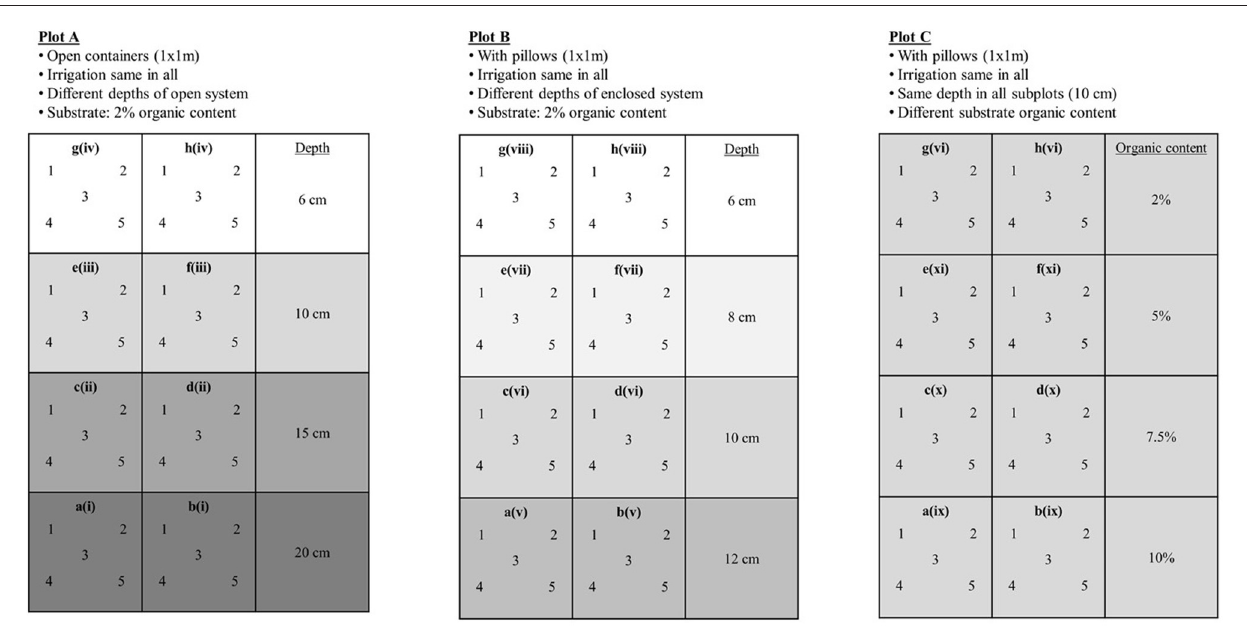
FIGURE 2 | Set-up of the experimental site. Source: